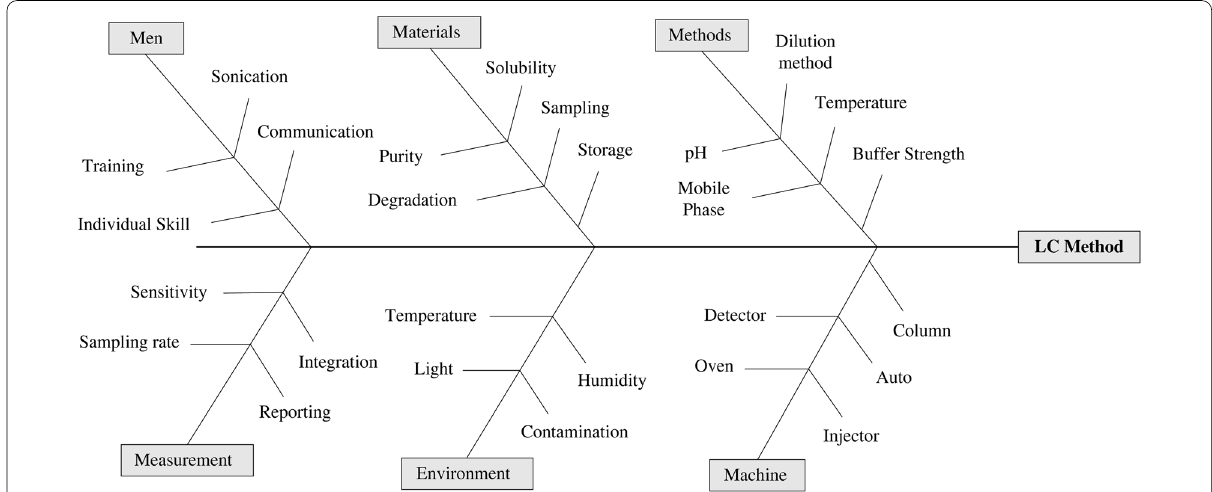
Fig. 4 Fishbone for potential risk